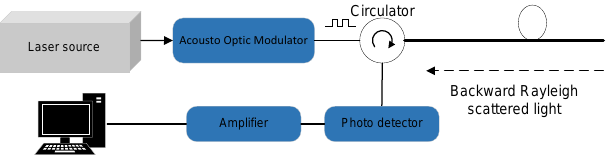
Figure 1. Φ -OTDR fiber optic system